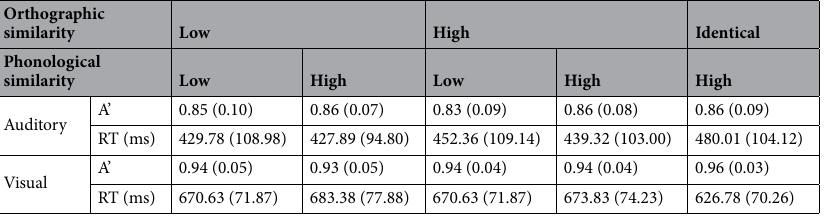
Table 2. By-subject means and standard deviations. Numbers in parentheses are standard deviations. The N in all cases is